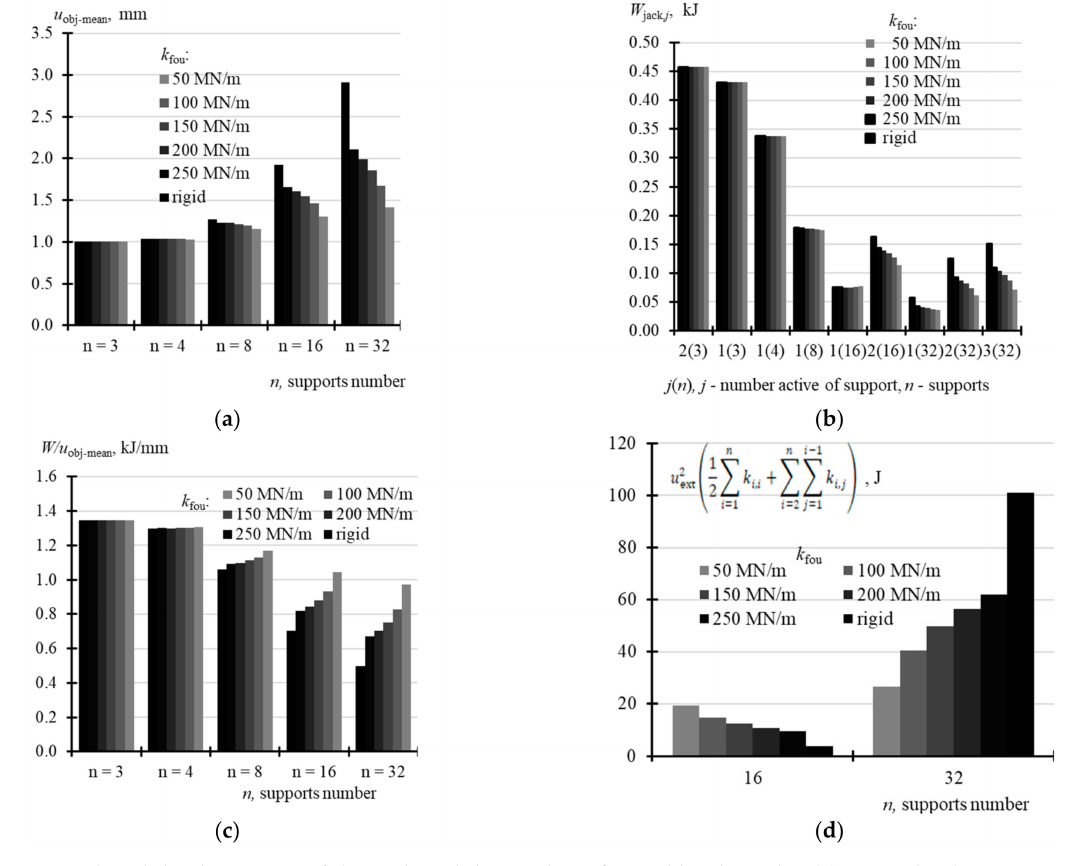
Figure 24. Analysed displacements of the tank and the work performed by the jacks: ( a ) mean displacements u obj-mean derived from the Equation (20) at u ext, j = 1 mm ( j = 1, . . . , n ); ( b ) work W jack, j performed by the active jack; ( c ) work W obtained from (19) divided by mean displacements u obj-mean from (20); ( d ) elastic energy of the deformed slab after forced displacements u ext, j = 1 mm ( j = 1, . . . , n ) of pistons in all the